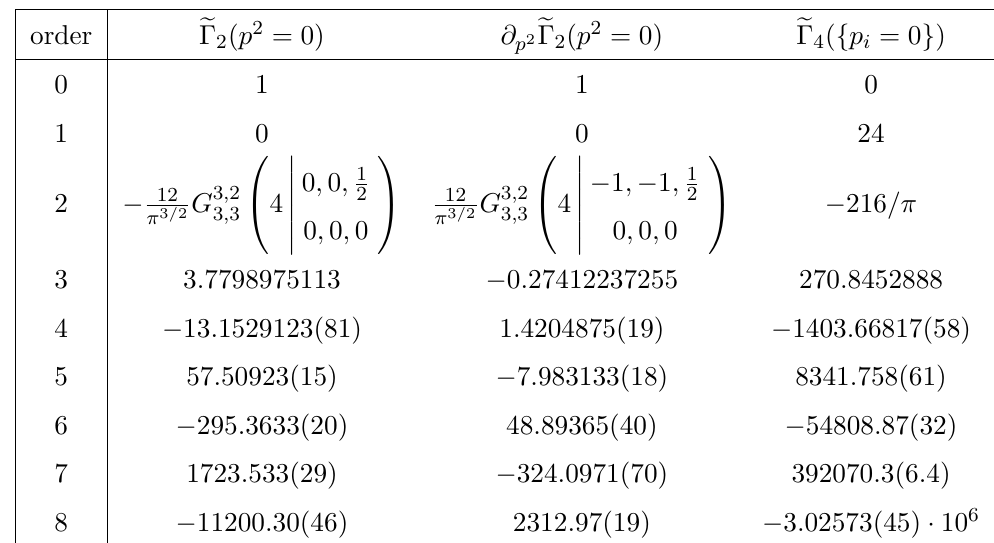
Table 10 . Series coe(cid:14)cients for the two point function e (cid:0) 2 , its derivative @ point function e (cid:0) 4 at vanishing external momenta. At order 2 the coe(cid:14)cients of e (cid:0) 2 and @ p 2 e (cid:0) 2 are expressed in terms of Meijer G-functions. At order 3 the coe(cid:14)cients are determined numerically with arbitrary